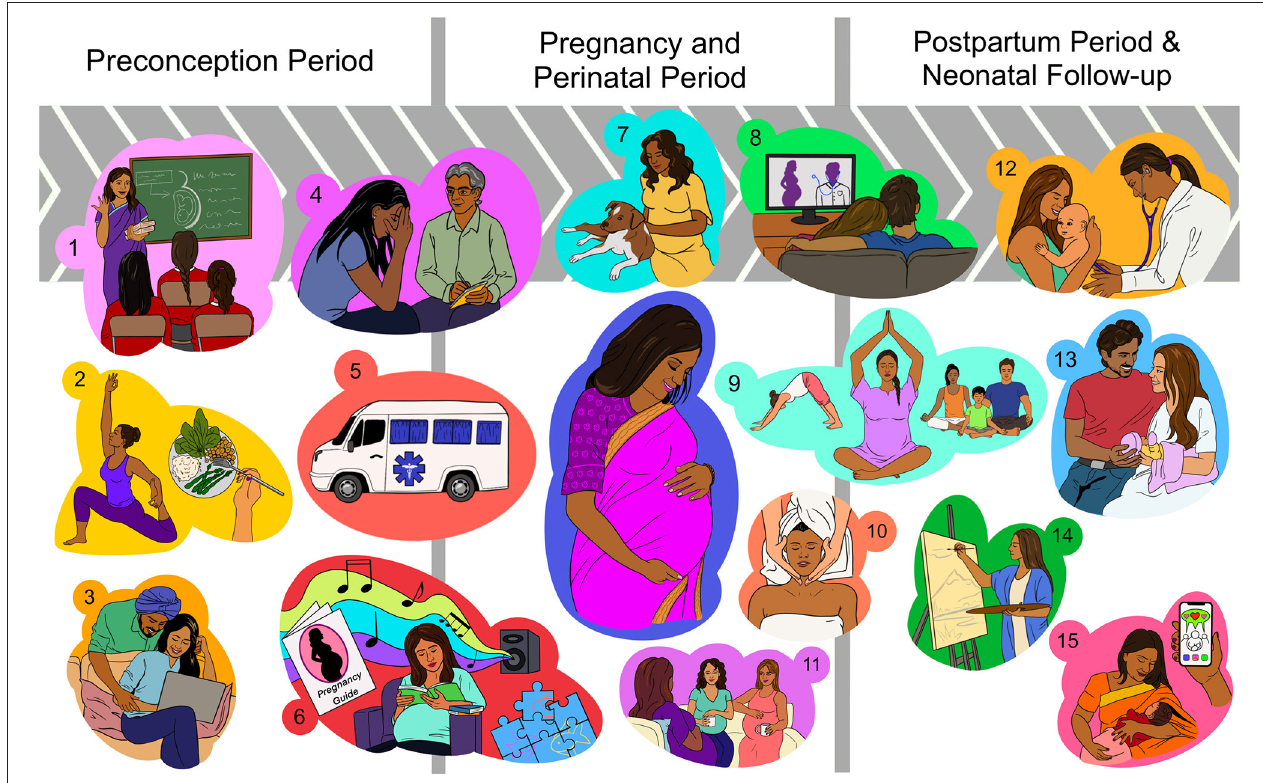
FIGURE 2 | Proposed interventions to promote healthy pregnancy outcomes and reduce maternal stress before and during pregnancy, and after delivery. (A) Preconception period: (1) Providing health education in schools, colleges, and awareness programs to prepare women for their reproductive life; (2) Providing counseling on nutrition and lifestyle modification; (3) Educational webinars and counseling for young couples planning pregnancy; (B) Pregnancy and perinatal period: (4) Mental health counseling during each antenatal visit; (5) Mobile health clinics for public awareness, diagnosis, referrals, and emergency care in remote areas; (6) Practicing relaxing activities such as listening to music, reading a book, knitting, gardening, walking in a park, puzzle-solving, and setting goals. Providing free pregnancy handbooks (with easy-to-understand pictorial information) in public places such as supermarkets, shops, bus stops, and train stations; (7) Spending time with a pet animal; (8) Watching pregnancy health documentaries or a comedy show with the family to lighten up the mood; (9) Practicing pregnancy yoga, meditation, and moderate exercises; (10) Massage therapy for both the parents; (11) Socializing with other pregnant women and sharing each other’s feelings; (C) Postpartum period: (12) Encouraging regular neonatal health check-ups; (13) Maternal and paternal stress counseling and guidance for mind exercises, relaxing activities to mitigate the stress; (14) Expressing inner thoughts through painting, expressive writing; (15) Joining nursing mothers’ groups and other social support groups on social media and sharing each other’s